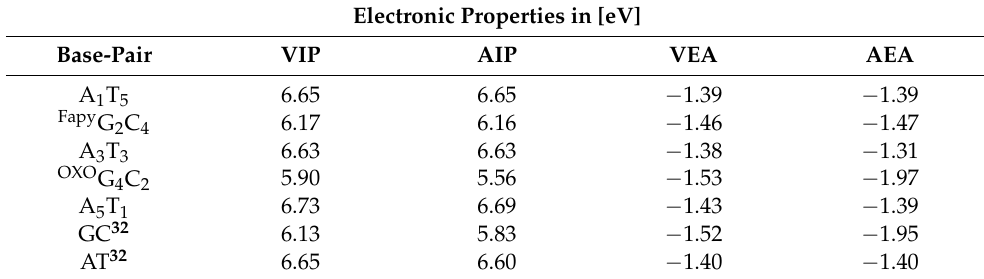
Table 3. Electronic properties of isolated base pairs from oligo- Fapy G: vertical (VIP), adiabatic ionization potential (AIP), and vertical (VEA) and adiabatic (AEA) electron affinity calculated at the M062x/6-31++G** level of theory in the condensed phase. The row data has been given in supplementary materials Table